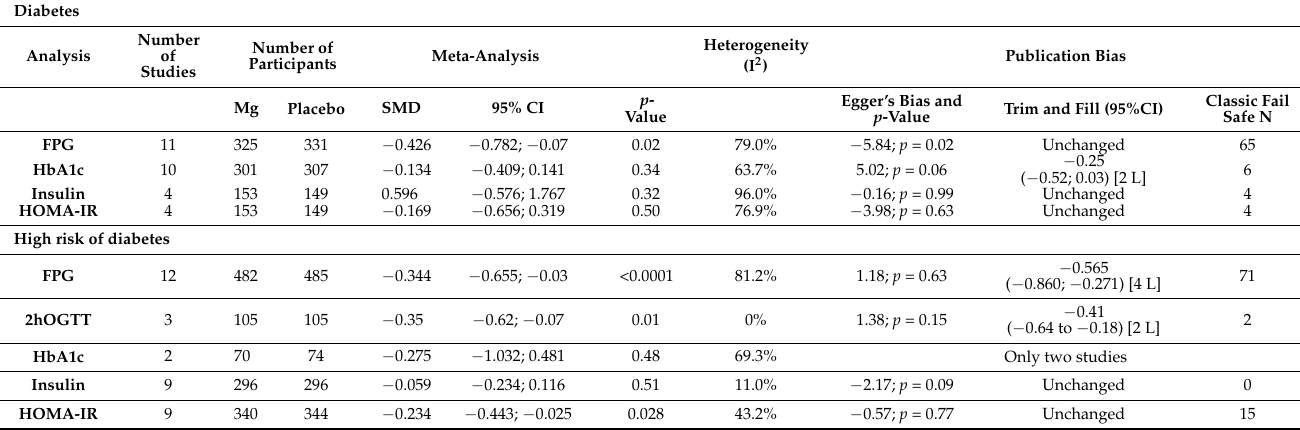
Table 1. Meta-analysis of eligible studies in diabetes and in conditions at high risk of diabetes.